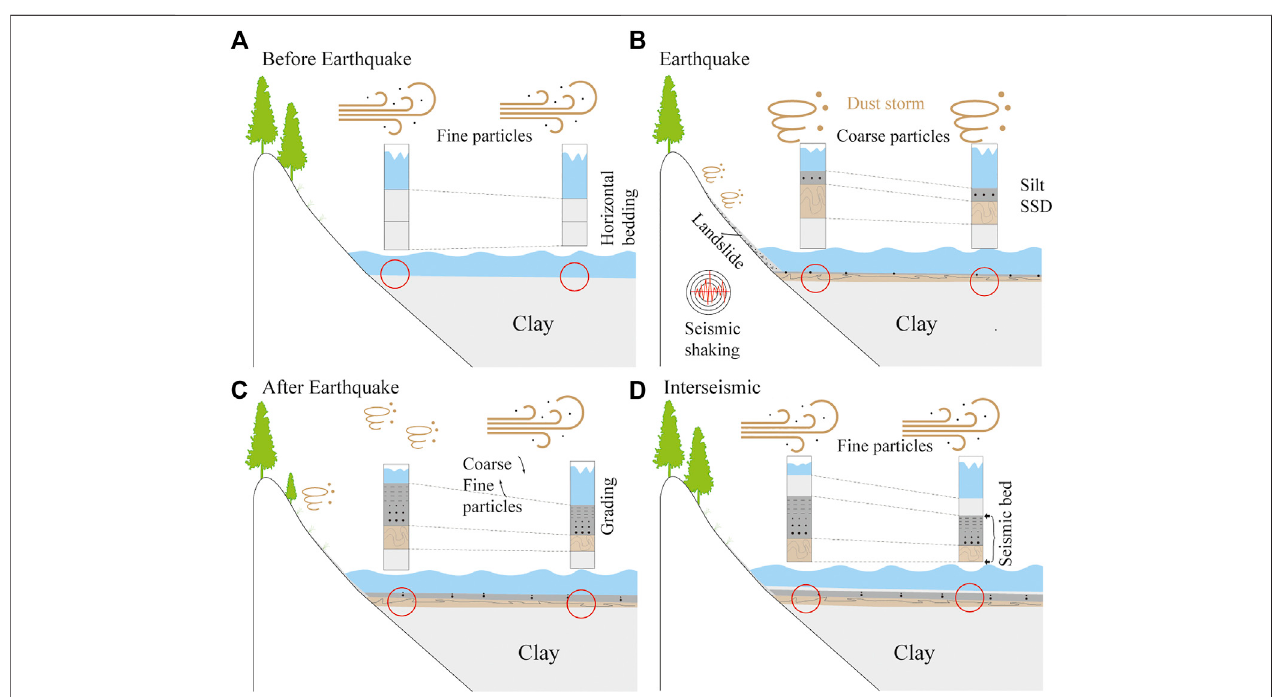
FIGURE 3 | Conceptual model of seismic layers (A) Background dust deposition before earthquake, with horizontal bedding (B) The earthquake shaking not only causes deformation of the water-saturated sediments but also provides abundant fresh coarse particles through dust storms, large quantities of landslides and surface loosening (C) As the landscape and vegetation restore, coarse particles decrease while fi ne particles increase (D) The source of lake sediments restores to its pre- earthquake level, and a seismic event layer is recorded.